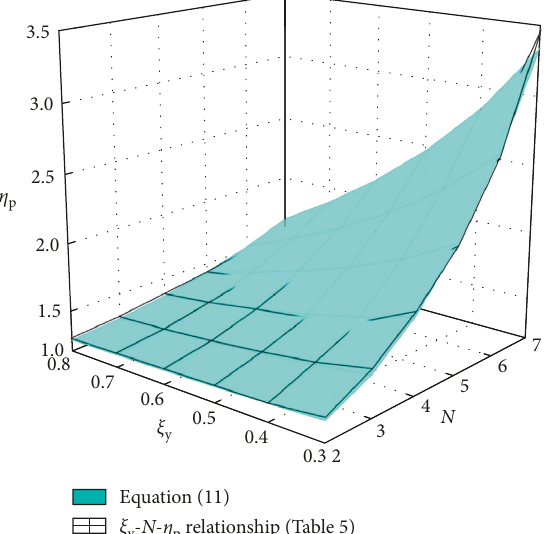
Figure 18: Comparison of the fitting equation (11) with the suggested ξ